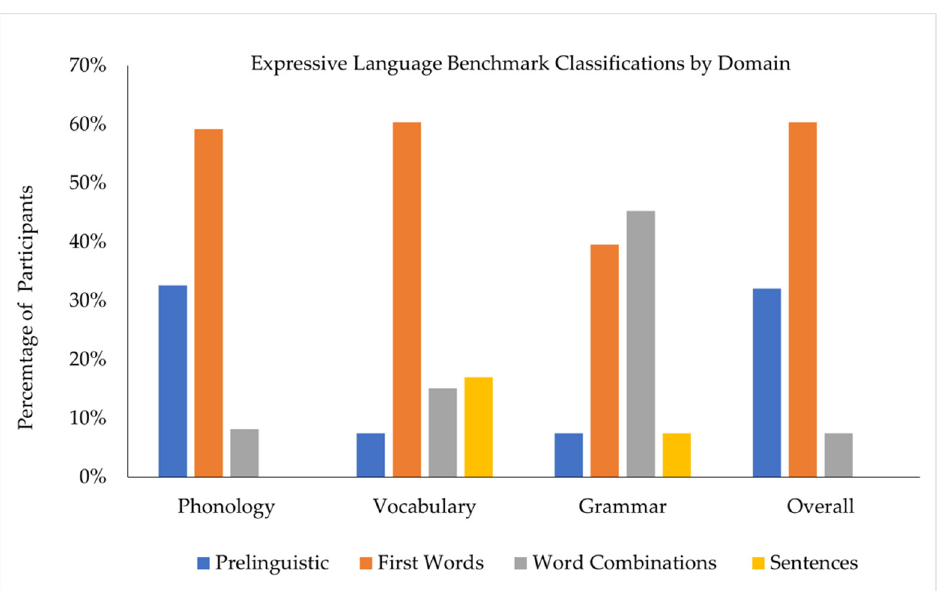
Figure 1. Expressive Language Benchmarks as a Function of Language Domain. Note. Phonology domain sample size = 49 (due to incomplete GFTA-3 administrations or examiner error). Overall ELB classifications were not impacted by the missing GFTA-3 scores.